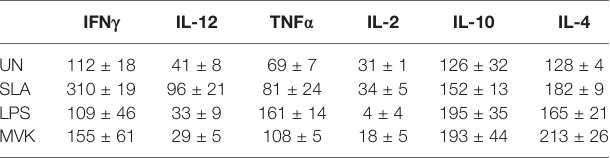
Unstimulated culture was used as a